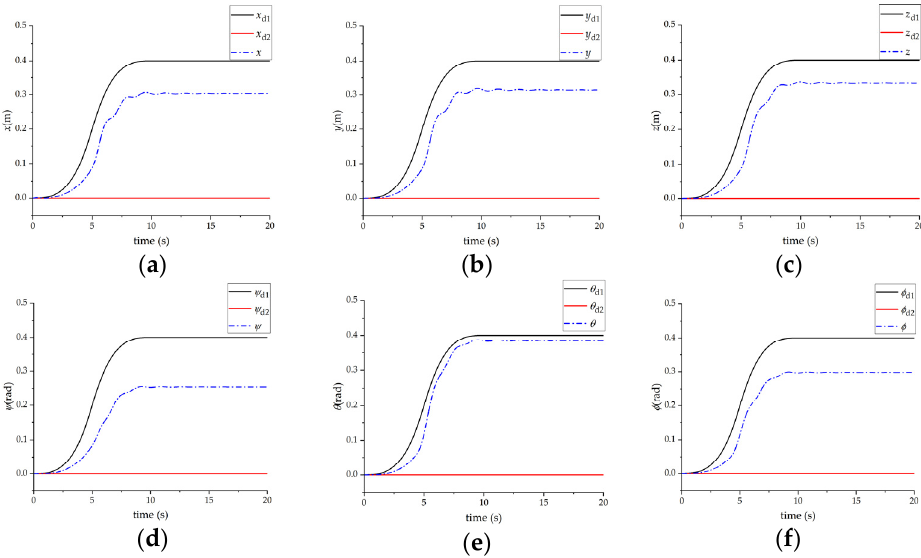
Figure 12. Pose of the virtual object in a state of mutual antagonism: ( a ) the x component; ( b ) the y component; ( c ) the z component; ( d ) the φ component; ( e ) the θ component; and ( f ) the ψ component. According to Figure 12, the final position of the virtual object is neither the target position of astronaut 1 nor the target position of astronaut 2, but a position somewhere in between. Moreover, the final position of the virtual object appears closer to the target position because astronaut 1’s maximum output force of astronaut 1 is larger. Based on Figure 12, under the same controller parameters,